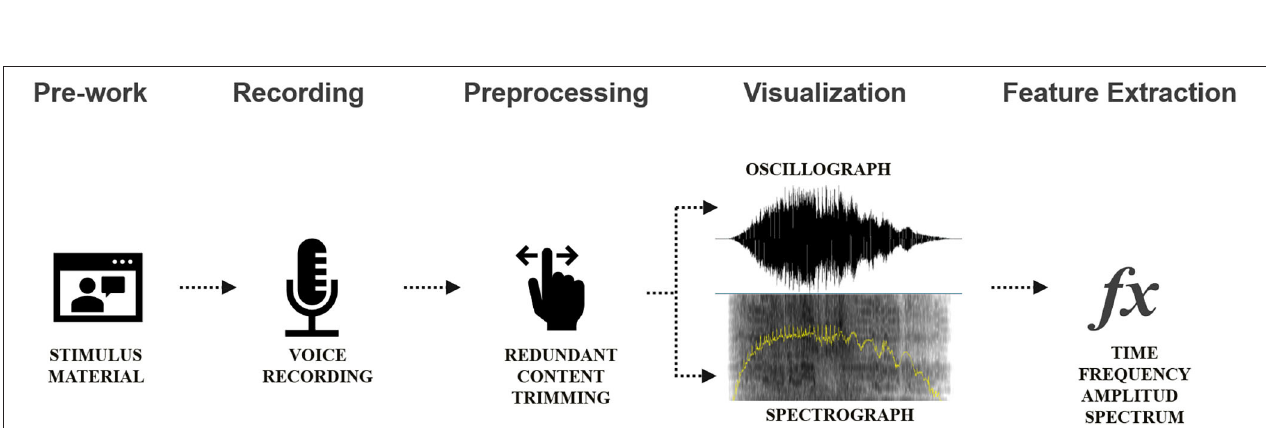
FIGURE 2 | Emotional induction and guidance cases during voice recording of different emotions. (A) Emotional stimulus is induced. (B) Text to remind the emotion, and then record. Subsequently, (C) Interval shady, and then enter the next emotional stimulus to induce. The complete contents are shown in the Appendix: Supplementary Material .